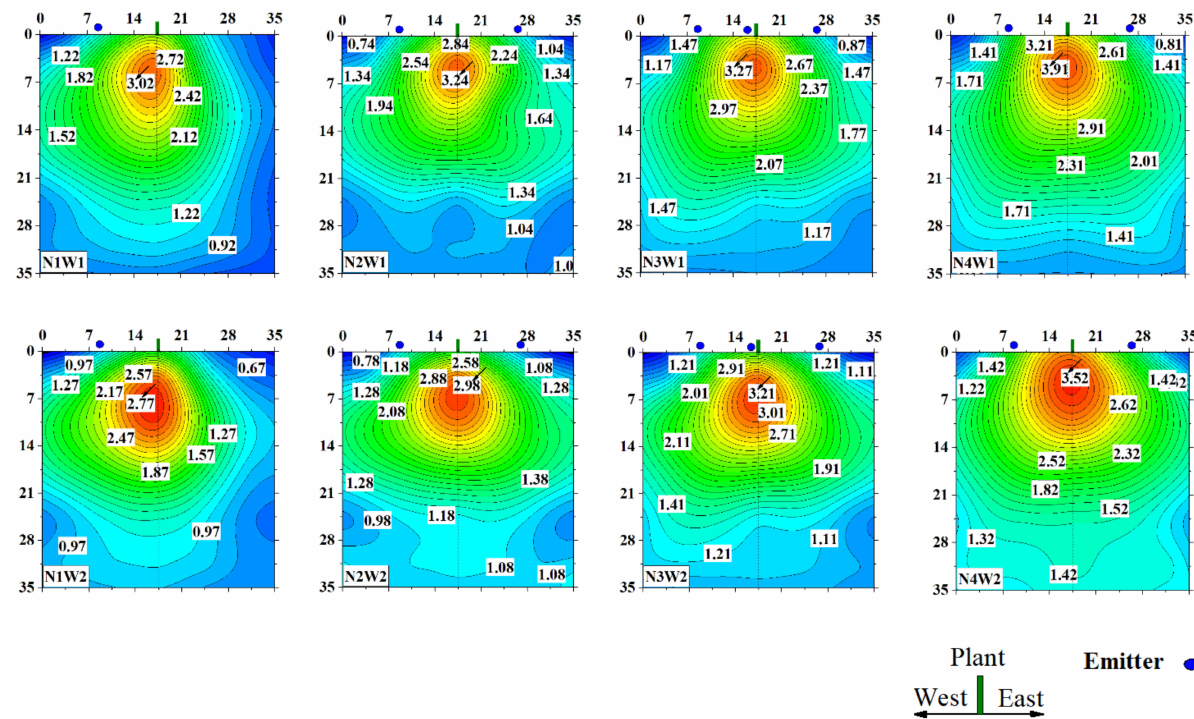
Figure 6. Effects of emitter density and irrigation levels on vertical root length density (RLD, cm cm − 3 ) distribution for the fall-winter cropping season (at the end of the cropping season; the maximum value is marked by a solid arrow).